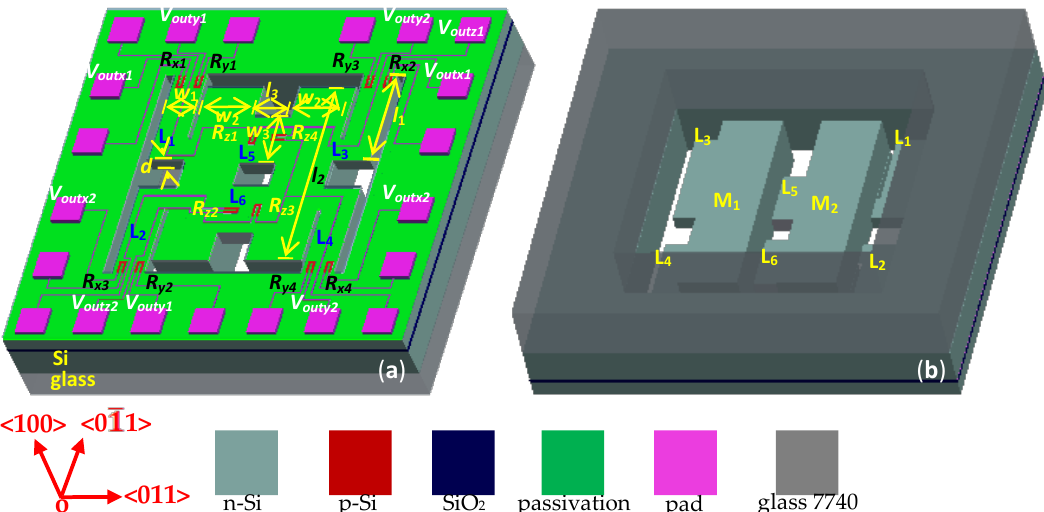
Figure 1. Basic structure of the silicon-on-insulator (SOI) three-axis acceleration sensor: ( a ) top view and ( b ) back view.